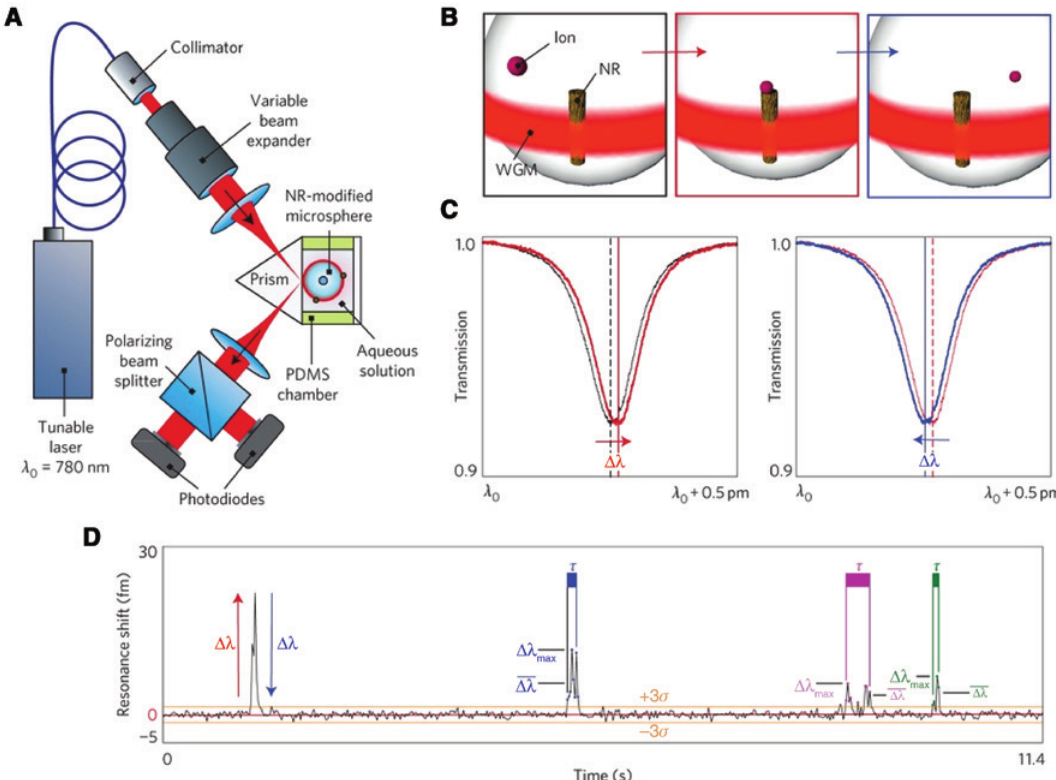
Figure 14: WGM sensing technique for single-ion detection. (A) Experimental configuration for prism-based excitation and probing of optical WGMs. (B) and (C) Zinc and mercury ions transiently inter- acting with bound gold nanorods, generating a redshift when encountering and then a blueshift when leaving the hot spot. (D) Time trace of the resonant wavelength wherein there are discernable ion detection events. Reprinted from